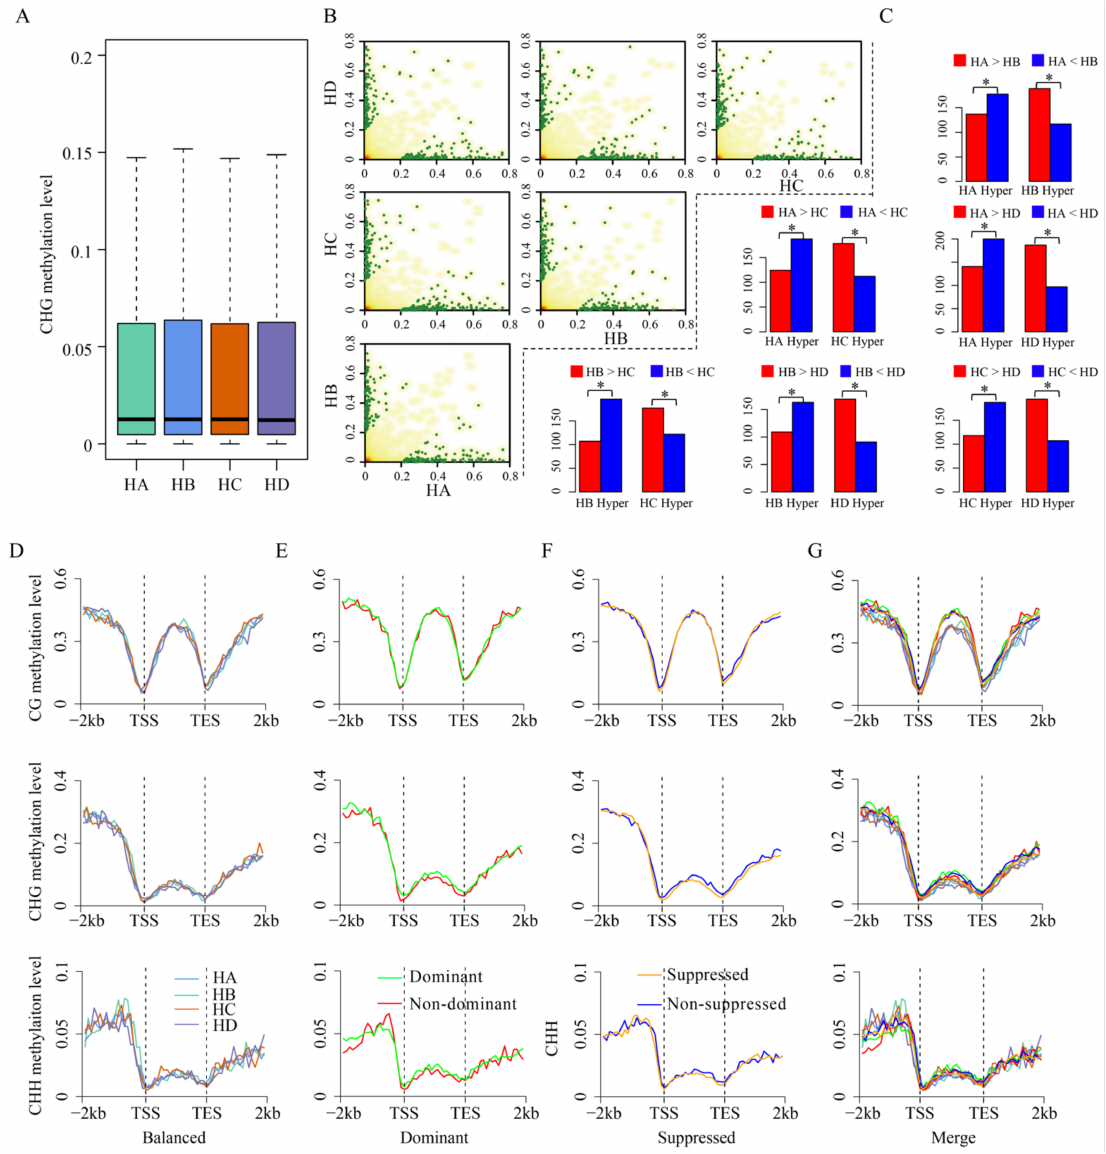
Figure 2. DNA methylation variation and association with expression of tetrad alleles. ( A ) Boxplot showing CHG methylation level of tetrad alleles from different haplotype chromosomes. ( B ) Pairwise comparison of CHG methylation level among four groups of homologous chromosomes. ( C ) Com- parison of the number of homologous alleles with different gene body methylation and expres- sion. The differences between homologous alleles were tested using the Wilcoxon rank sum test. * p value < 0.05. ( D – G ) DNA methylation profile of balanced ( D ), dominant ( E ), suppressed ( F ), and merged ( G ) tetrad alleles in CG, CHG, and CHH sequence contexts,